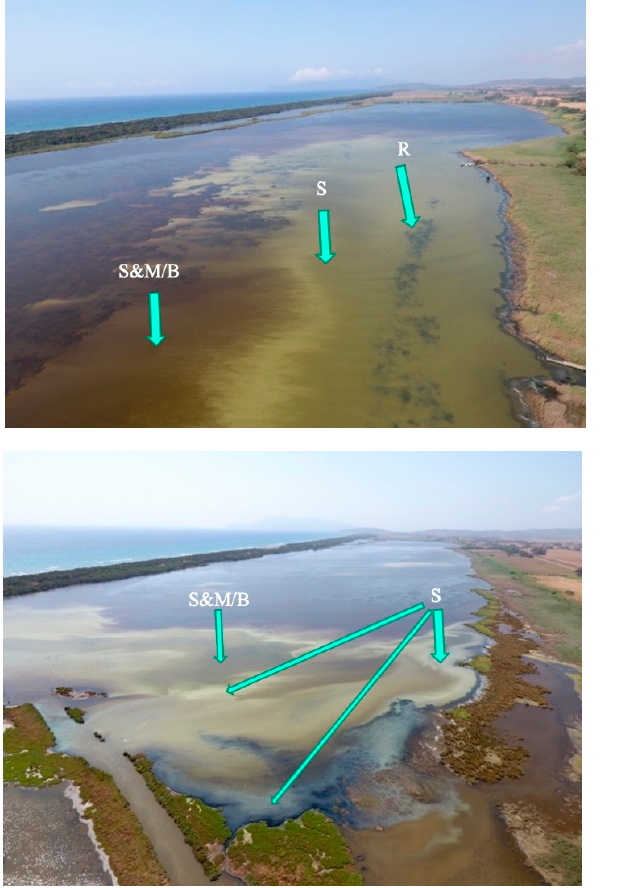
nanoparticulate with colloidal sulfur (S&M/B arrow). Top right image, detail of the area affected by area affected by dystrophy. Lower left image, extensive dystrophic phenomenon that affected the